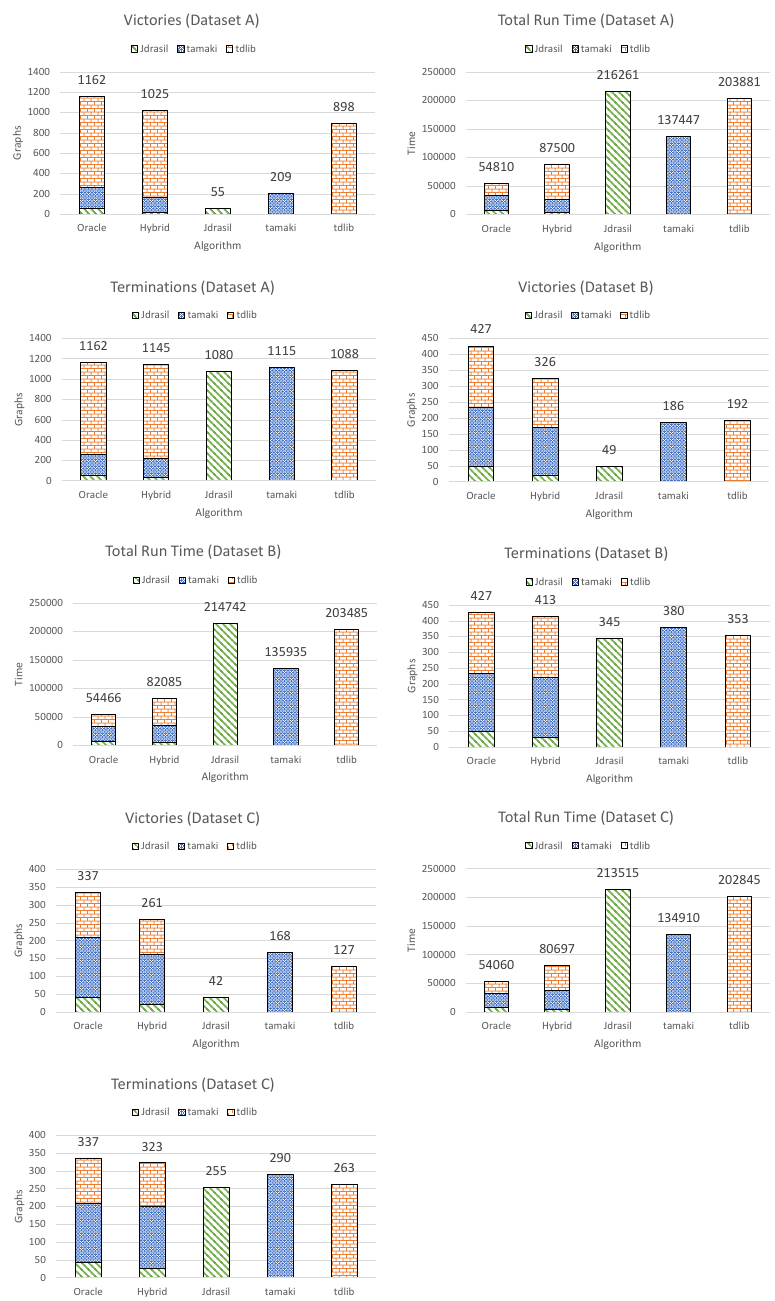
Figure 1. Experimental results using Leave-One-Out cross-validation. Each chart presents the results from the experiment on one of the three datasets (A, B and C) based on one of the three performance metrics (victories, total run time and terminations). For the Oracle and Hybrid algorithms, results are not presented as an aggregate of all solver choices—instead, each solver’s contribution to each performance metric is presented separately (see Sections 4.2 and 4.3). Total running times are measured in